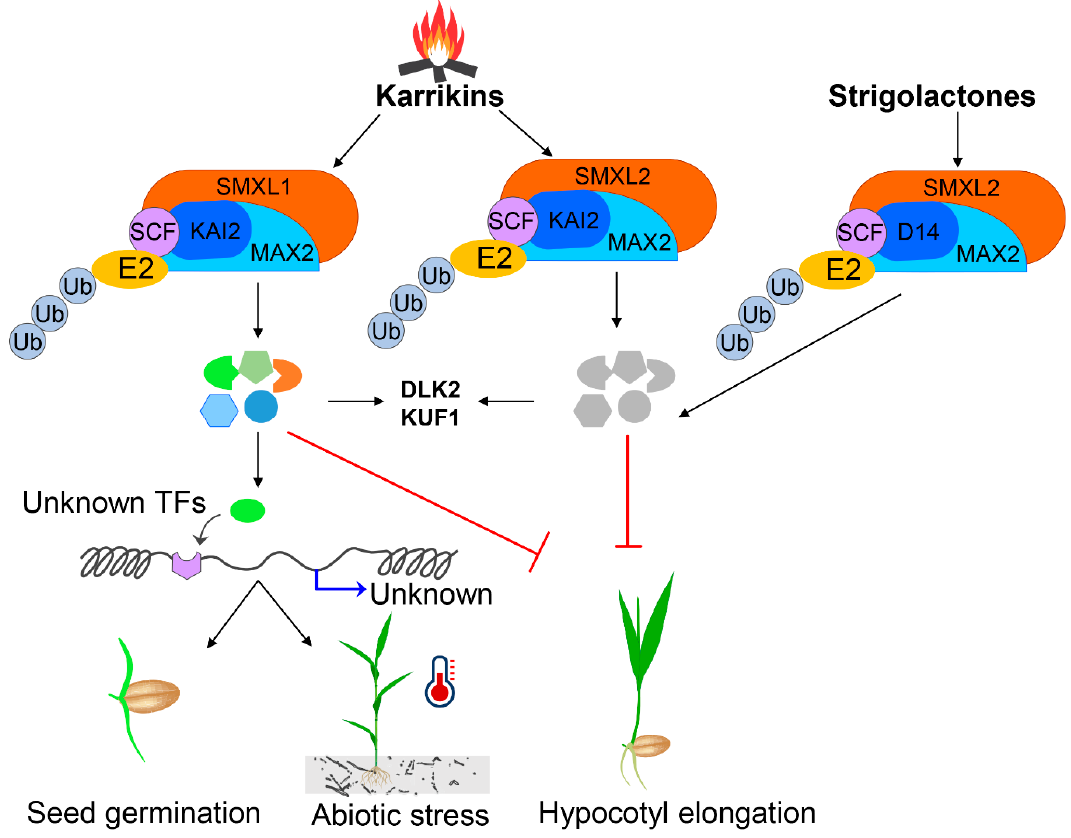
Figure 3. Proposed model of strigolactone and karrikin-assisted germination and abiotic stress tolerance pathways for agricultural crops. The figure has been re-drawn and modified from (Wang et al., 2020; Yao and Waters, 2020; Morffy et al., 2016).